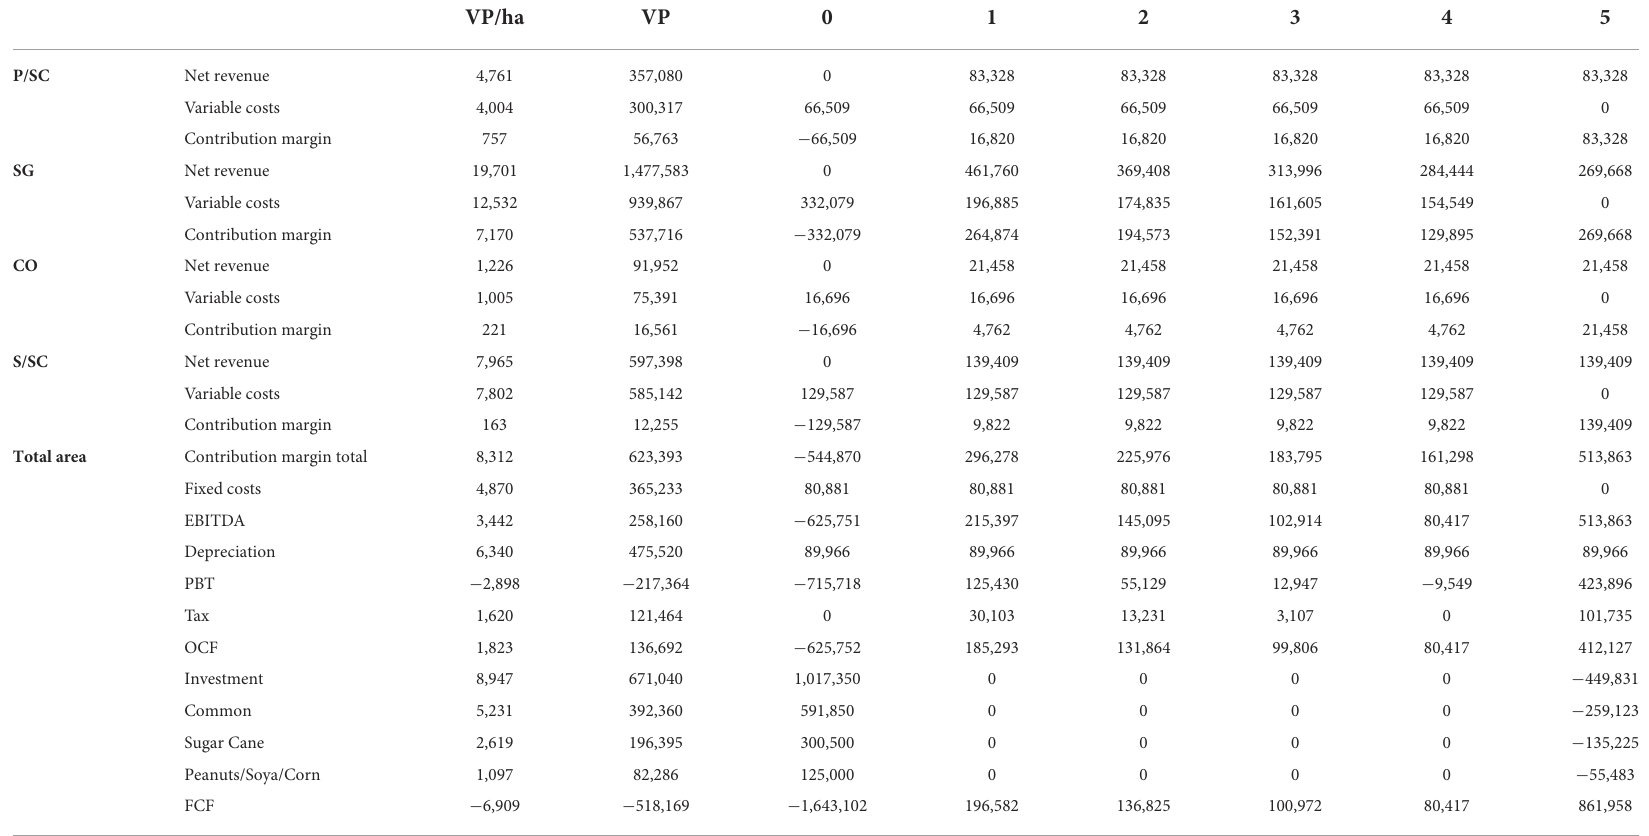
TABLE 8 Cash flow from modal farm per hectare, and total under crop